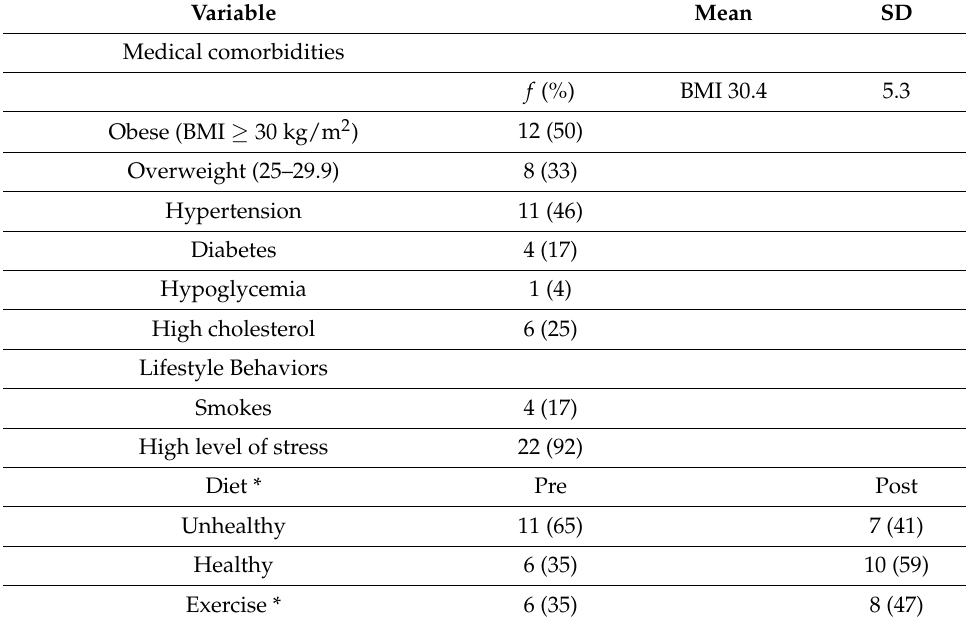
Table 3. Medical comorbidities and lifestyle characteristics of the 24 participants.